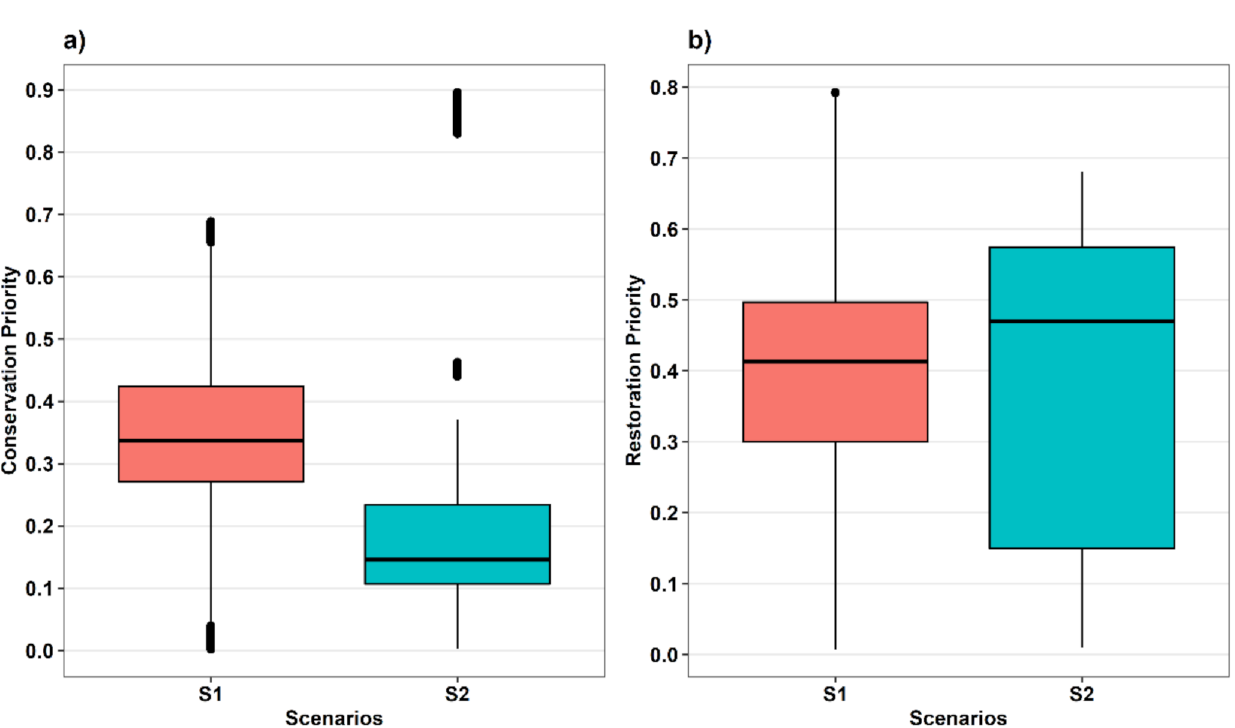
Figure 1. Distribution of ( a ) conservation priority values and ( b ) restoration priority values for the different